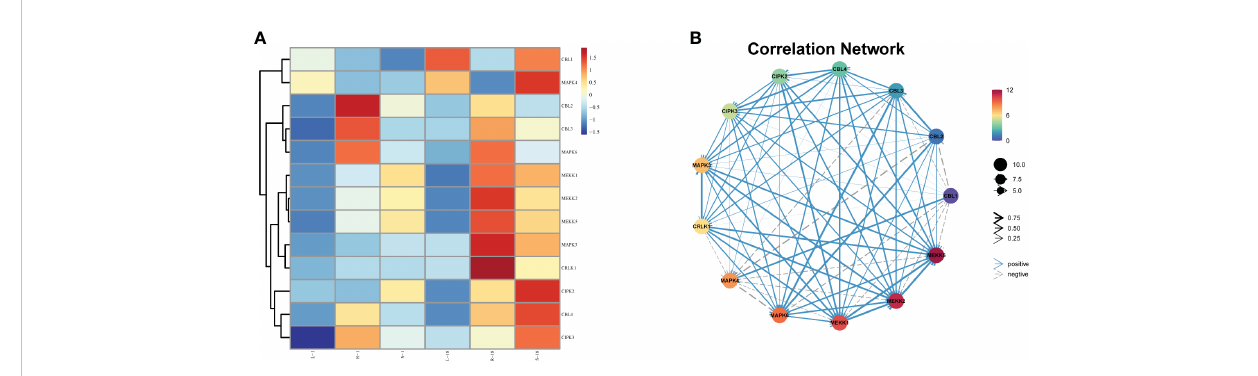
FIGURE 5 Identi fi cation of CBL-CIPK network and MAPK cascade gene genes in different tissues of K. obovata seedlings and visualization of their co- expression networks. (A) Hierarchical clustering analysis of 13 CBL-CIPK networks and MAPK cascade genes. The values in the heat map indicate the z-normalized values of FPKM in different samples. Red and blue colors indicate high and low expression levels, respectively. (B) Thirteen ICE- CBL- CIPK network and MAPK cascade gene co-expression